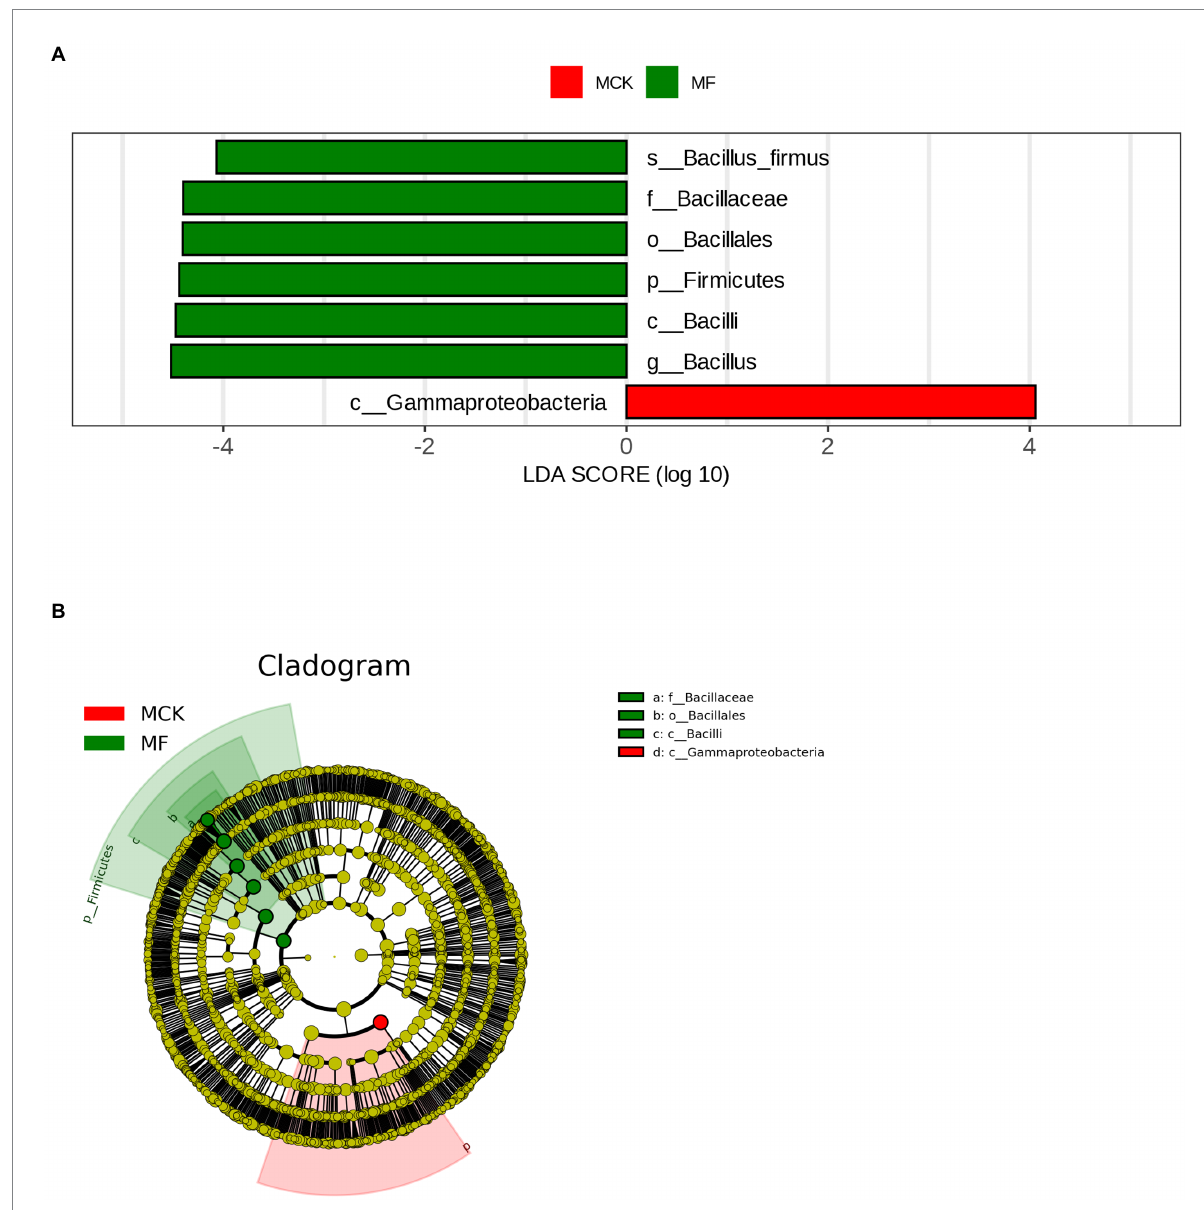
FIGURE 2 (A) Histogram shown by LEfSe for the computations of LDA score (LDA score ≥ 4) for dominant bacterial taxa (biomarker) between control group (MCK) and treatment group (MF) of Cucumis melo var. saccharinus. (B) Cladogram demonstrating the significantly dominant bacterial taxa for both MCK and MF at each taxonomic